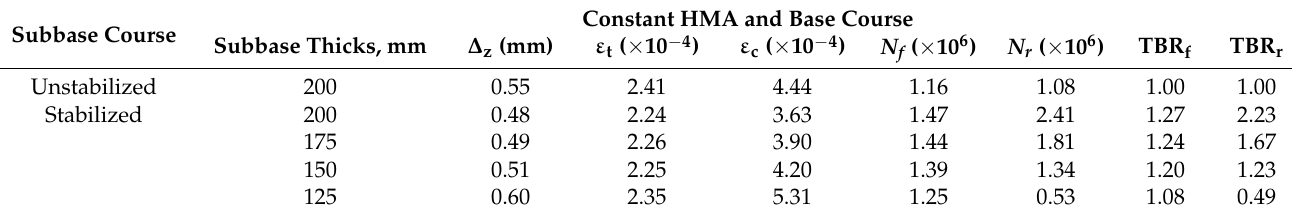
Table 7. Results of mechanistic–empirical